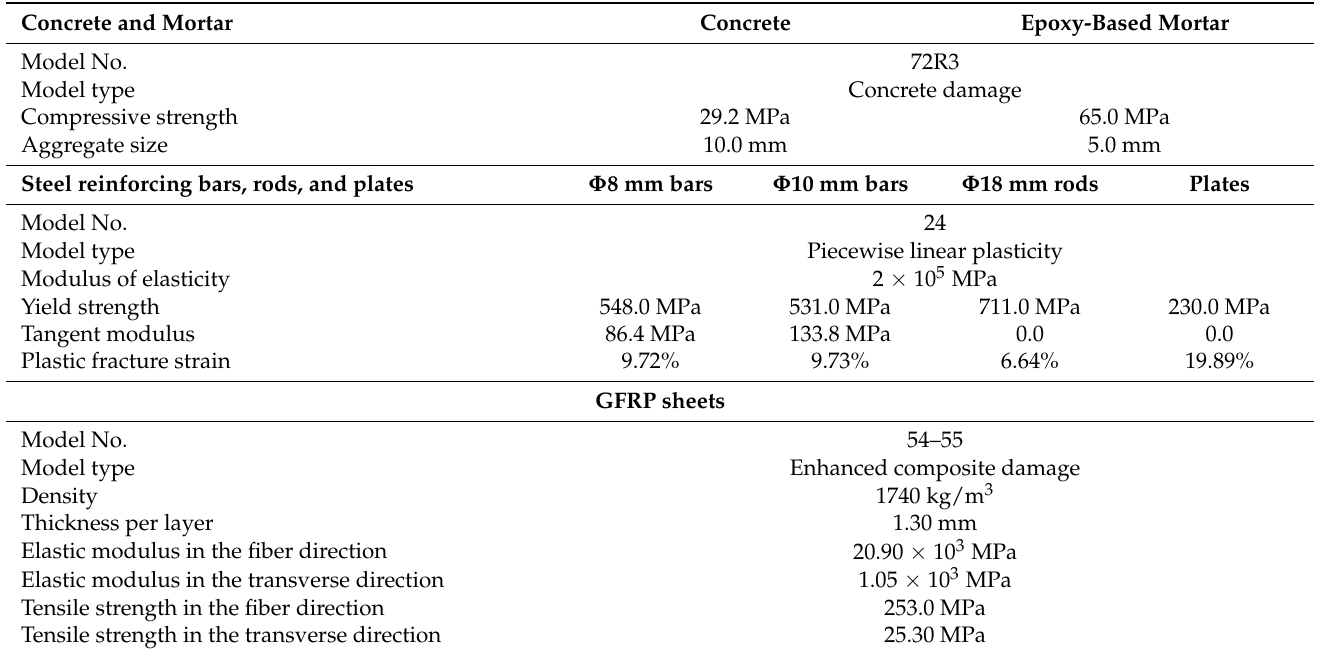
Table 2. Key FE input parameters for constituent materials.